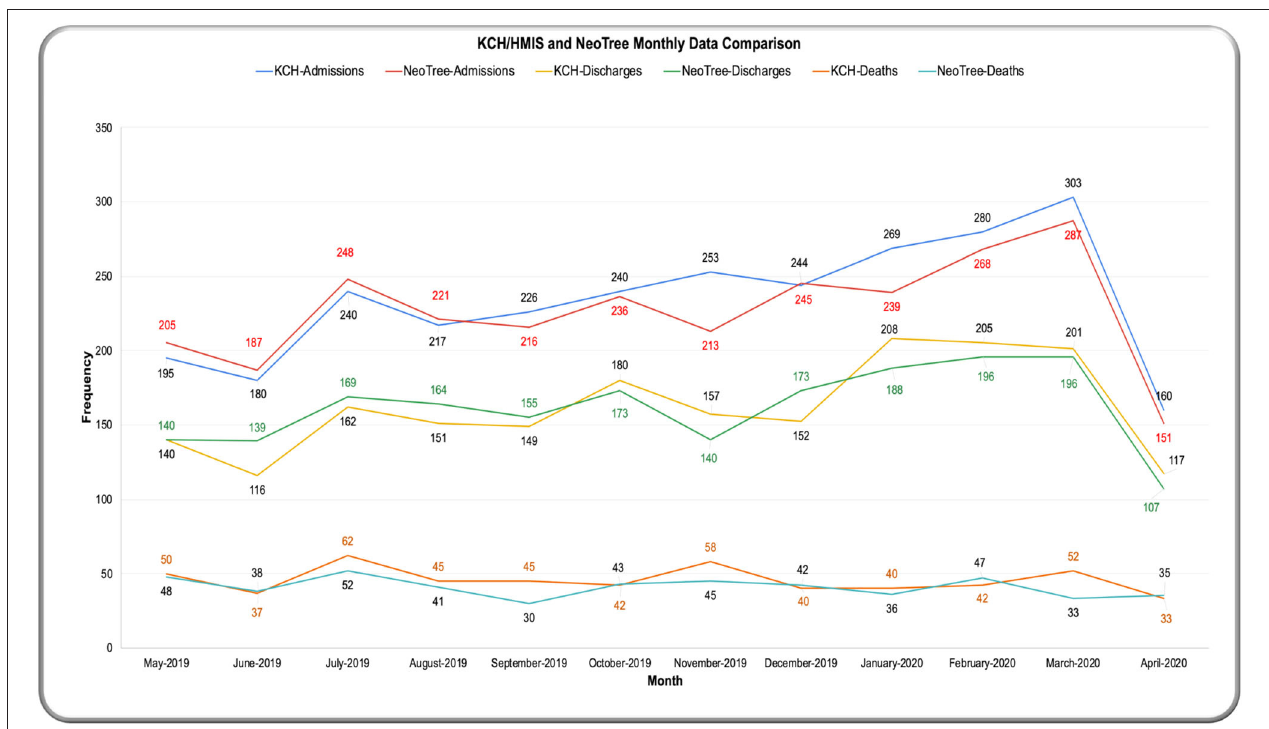
FIGURE 11 | Coverage—admissions and outcomes collected by KCH data clerk and